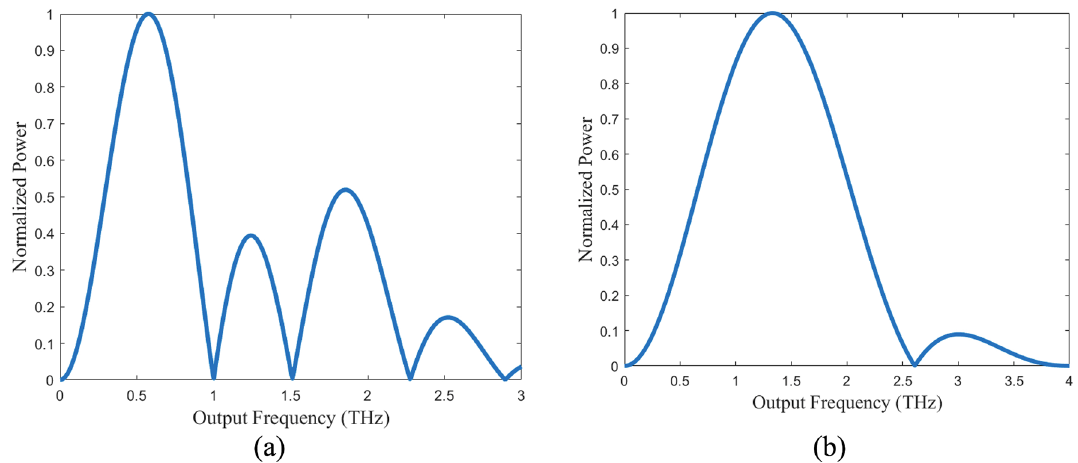
Figure 7. Simulated frequency spectra for the non-equilibrium transport arc model. ( a ) Frequency spectrum of the 0.5 THz system. A peak occurs at 0.57 THz with secondary peak occurring at 1.8 THz. A tertiary peak occurs at 1.25 THz, previously not predicted by the dipole model. ( b ) Frequency spectrum of the 1 THZ system. A peak occurs at 1.33 THz with a secondary peak at 3